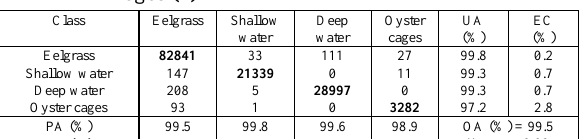
Table 10. Confusion matrix (in pixels) and associated accuracies when the RF classifier is applied to the original band reflectance images, vegetation indices, and bathymetric ratios for the three Richibucto